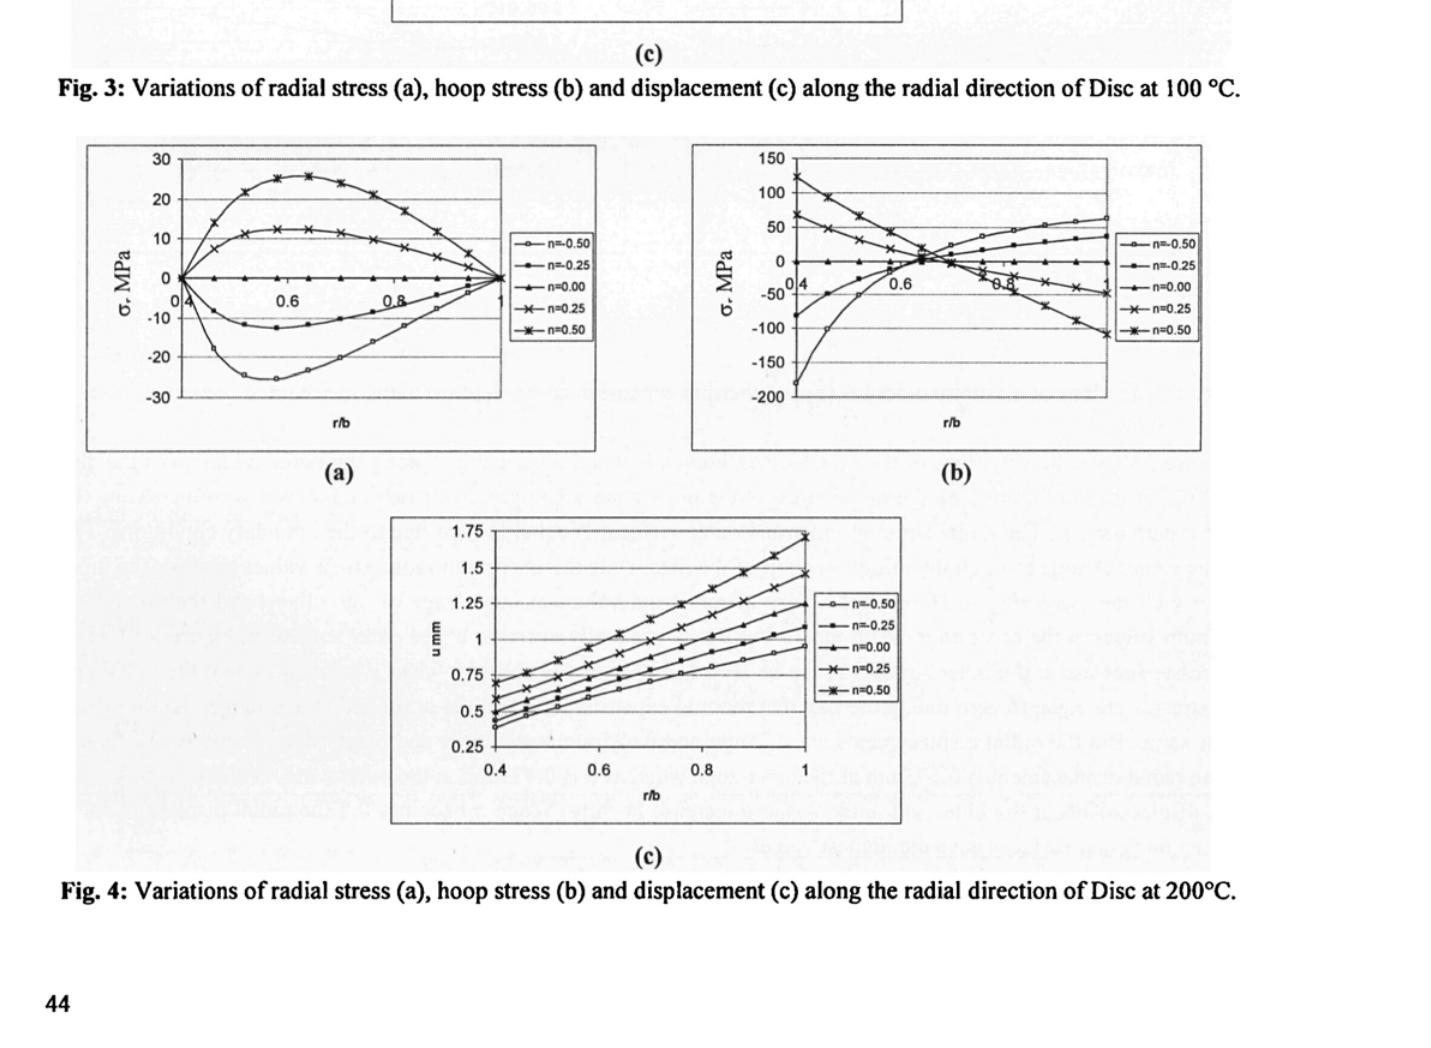
Fig. 4: Variations of radial stress (a), hoop stress (b) and displacement (c) along the radial direction of Disc at